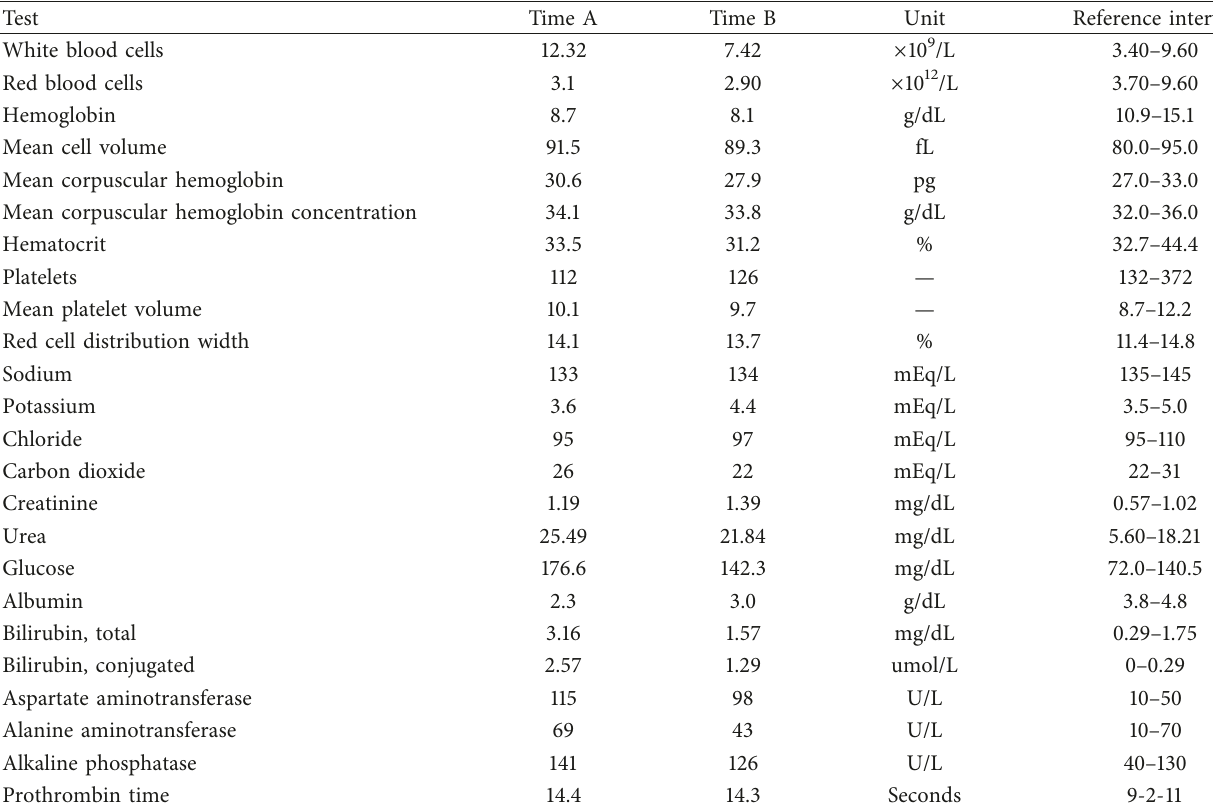
Table 1: Values of initial laboratory tests during the two respective hospitalizations.